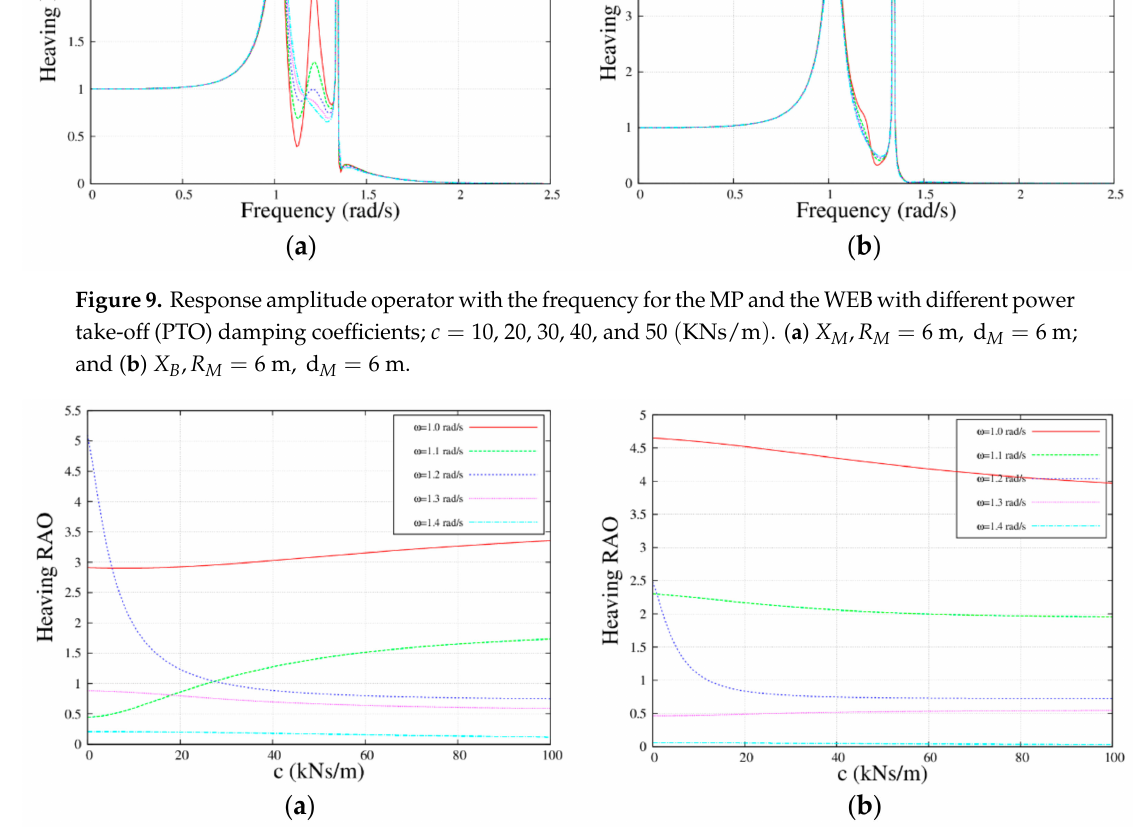
Figure 10. Response amplitude operator with the PTO damping coe ffi cient for the MP and the WEB with di ff erent frequencies; ω = 1.0, 1.1, 1.2, 1.3, and 1.4 ( rad/s ) . ( a ) X M , R M = 6 m, d M = 6 m; and ( b ) X B , R M = 6 m, d M = 6